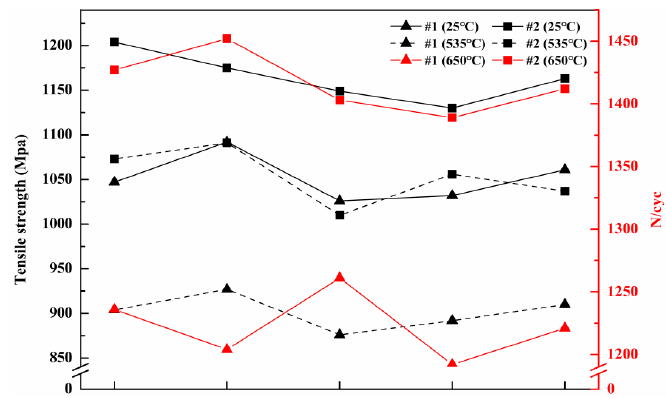
Figure 8. The mechanical properties of superalloy samples following different melting technologies.